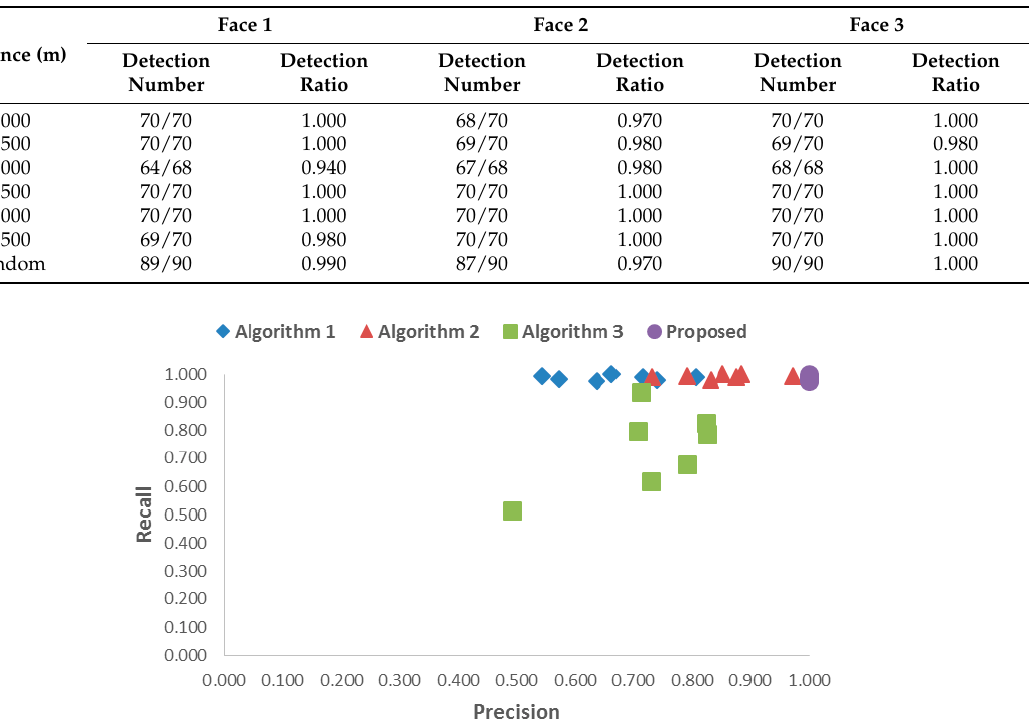
Table 1. Average precision and recall values for the proposed and benchmark algorithms at different distances.